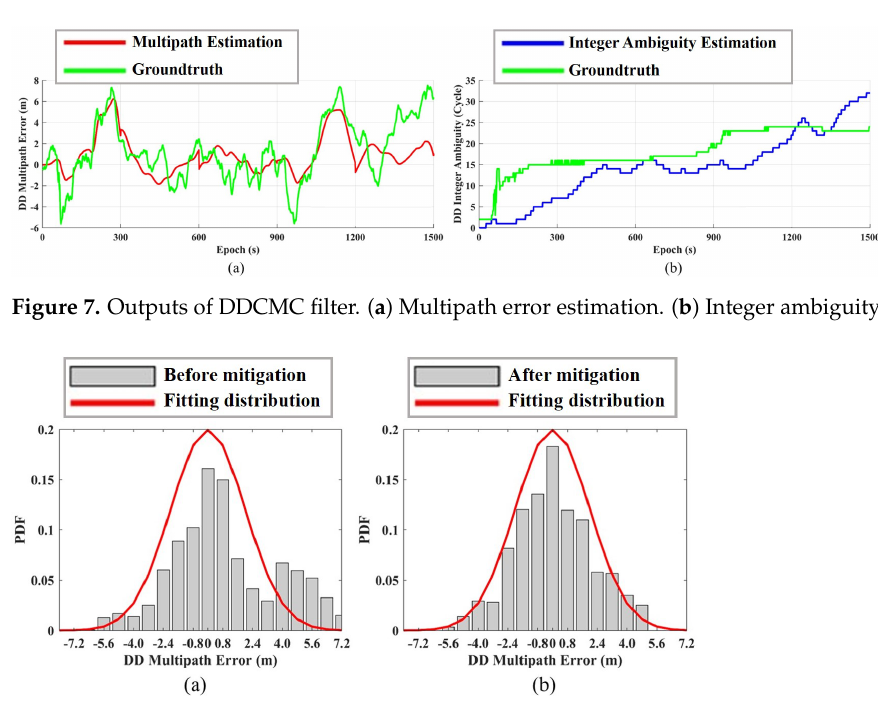
Figure 8. Probability density function of double-difference multipath error. ( a ) Before multipath mitigation. ( b ) After multipath